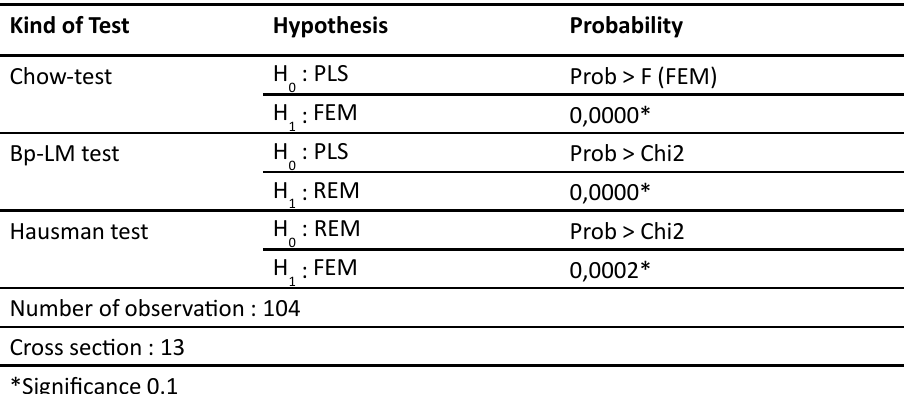
Table 2: Results of Testing Model